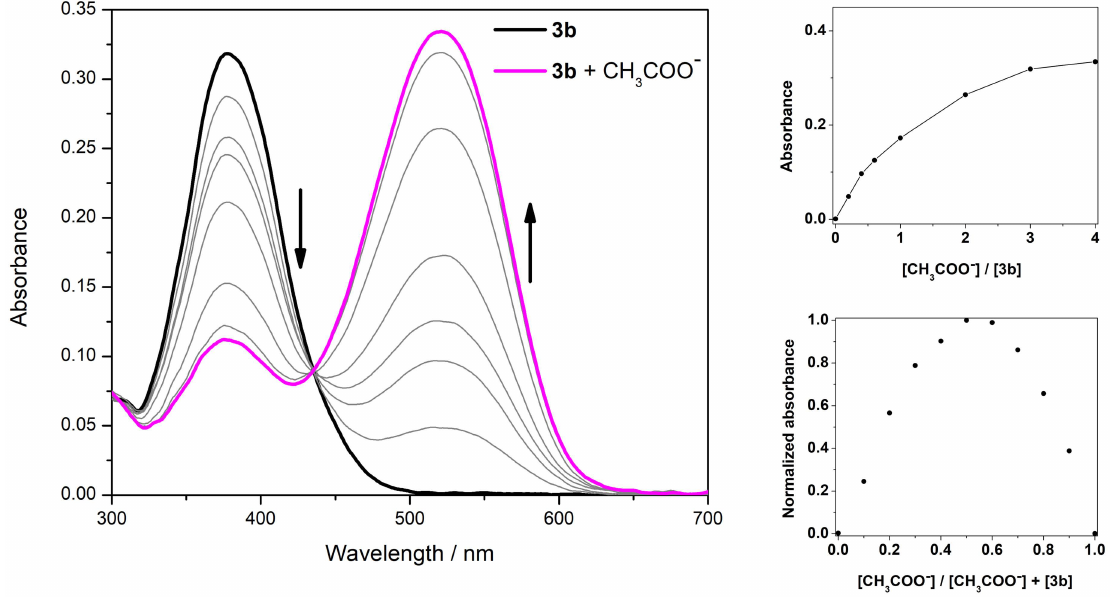
Figure 5. Photophysical interaction between compound 3b and CH 3 COO − (4 equiv. of CH 3 COO − required for maximum absorbance). Left —spectrophotometric titration of compound 3b with CH 3 COO − ; Top right —absorbance at 520 nm as a function of added ion equiv.; Bottom right —Job’s plot for the interaction (stoichiometry 3b 1:1 CH 3 COO −